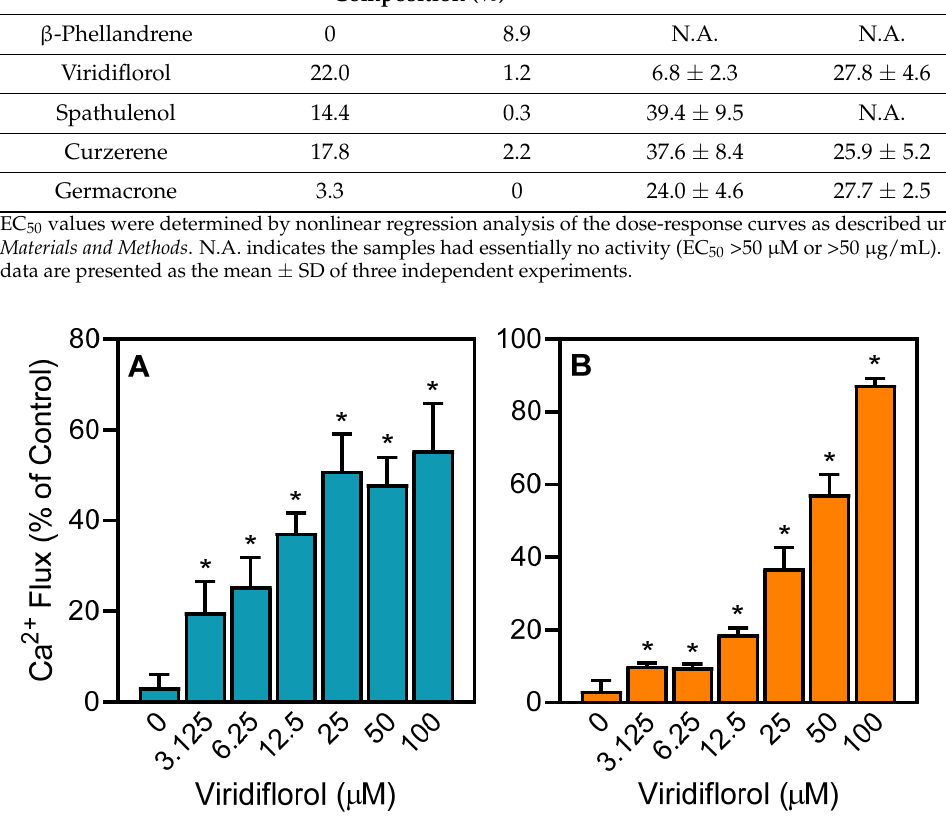
Figure 2. Effect of viridiflorol on neutrophil and microglial Ca 2+ mobilization. Human neutrophils ( A ) and human C20 microglial cells ( B ) were treated with the indicated concentrations of viridiflorol, and [Ca 2+ ] i was measured as described. The data are expressed as the change in [Ca 2+ ] i and compared to control [Ca 2+ ] i induced by 5 nM f MLF (100%) in neutrophils or 10 μ M f MLF (100%) in microglial cells and plotted as mean ± SD. The data presented are from one experiment that is representative of two independent experiments with similar results. * p < 0.01 compared to DMSO control [Ca 2+ ] i .